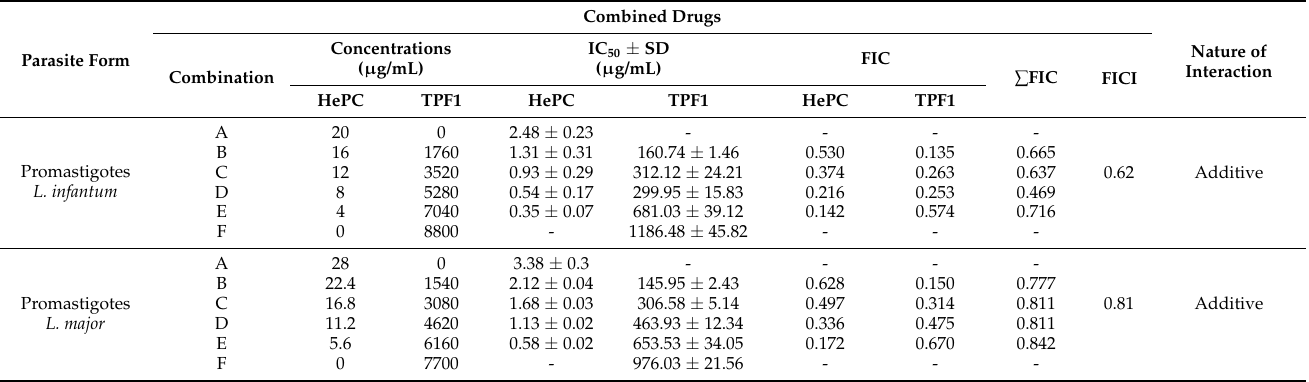
Table 3. IC 50s , FICs and ∑ FICs of TPF1 and HePC combinations against Leishmania infantum and Leishmania major promastigotes and intracellular